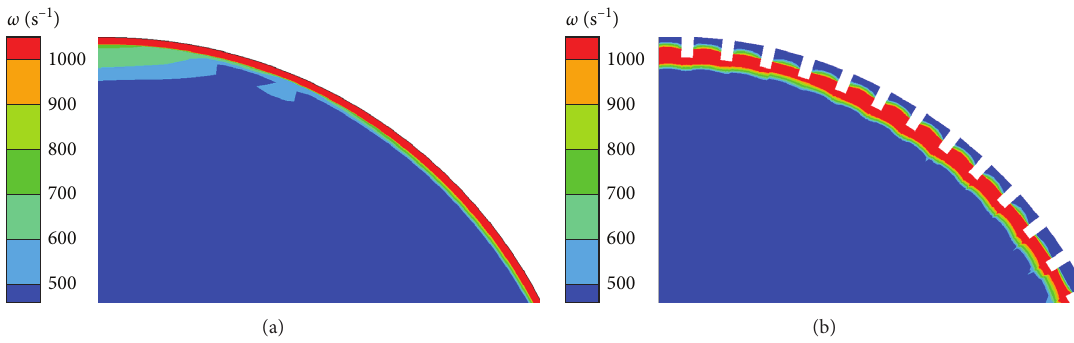
Figure 10: Diagram of vorticity: (a) original scheme; (b) selected scheme.